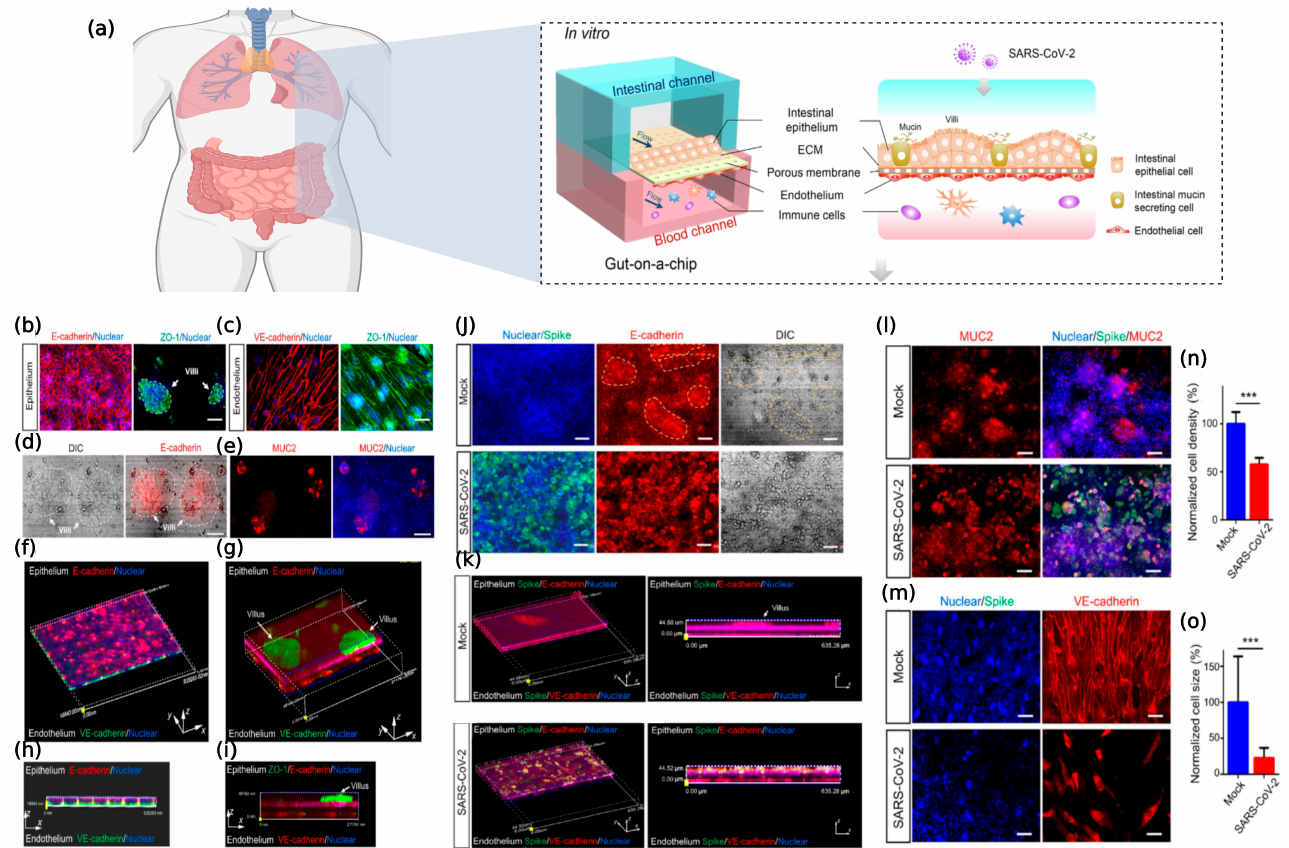
Figure 12. SARS-CoV-2-induced intestinal responses with a GLA-on-chip. ( a ) The configuration of the multilayered intestine on the chip device infected with SARS-CoV-2. ( b ) Confocal micrographs of the intestinal epithelial barrier on the chip visualized by the expression of an adhesion junction (E-cadherin) and tight junction markers (ZO-1). The intestinal villus-like structures with high levels of ZO-1 expression are indicated by white dashed lines. ( c ) Confocal micrographs of the vascular endothelium identified by the expression of an adhesion junction protein (VEcadherin) and ZO-1. ( d ) DIC image of an intestinal villus-like structure with clumps of cells (indicated by white dashed lines). ( e ) Immunostaining of a mucin marker (MUC2) in intestinal epithelial cells. Scale bars: 50 lm. ( f , h ) The 3D reconstructed confocal image and side view of the human intestinal epithelium (E-cadherin) and endothelium (VE-cadherin). ( g , i ) The 3D reconstructed confocal image and side view of the intestinal epithelium, endothelium, and intestinal villus-like structures (indicated by white arrows). ( j ) Confocal micrographs of SARS-CoV-2 infection (Spike protein) on the intestinal epithelium (E-cadherin) and intestinal villus-like structures (indicated by yellow dashed lines) at day 3 post-infection. Scale bars: 50 lm. ( k ) The 3D reconstructed confocal image and side view of a mock-infected gut-on-chip. The 3D reconstructed confocal image and side view of the virus-infected intestinal model. SARS-CoV-2 infection was identified in the epithelial layer by the expression of the viral Spike protein. ( l ) Confocal micrographs of SARS-CoV-2 infection (Spike protein) and MUC2 expression in the intestinal epithelium at day 3 post-infection. Scale bars: 50 lm. ( m ) Confocal micrographs of viral infection (Spike protein) in the vascular endothelium (VE-cadherin). Scale bars: 50 lm. ( n , o ) Quantification of endothelial cell density and size for mock- and SARS-CoV-2-infected chips. Four chips were counted for cell density quantification in each group, and 100 cells were counted for cell size quantification in each group. Data are presented as the mean ± SD and were analyzed by Student’s t-test (***, p < 0.001) [31] ©Copyright 2021, Elsevier.